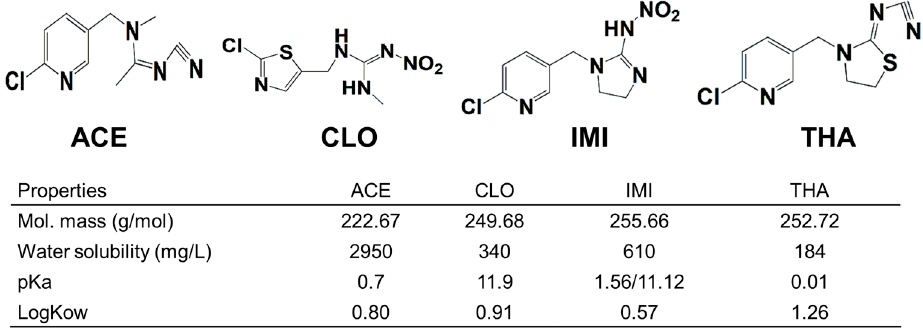
Figure 1. Molecular structures (top) and some chemical properties of ACE, CLO, IMI, and THA, respectively. Data are from PubChem (https://pubchtm.ncbi.nlm.nih.gov/, accsess on 5 October 2022) and PPDB (http://sittm.htrts.ac.uk/atru/ppdb/tn/indtx.htm, accessed on 1 September 2022) .